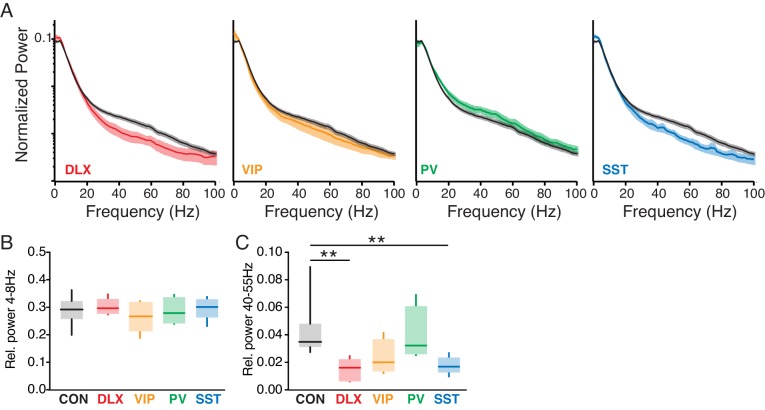
Altered hippocampal activity patterns in Mecp2 mutants.(A) Population-averaged normalized hippocampal CA1 power spectra during quiescent sitting periods for Dlx5/6 mutants (red; n = 5), VIP mutants (orange; n = 5), PV mutants (green; n = 4), and SST mutants (blue; n = 6) compared to Mecp2f/y controls (black; n = 9). (B) Population-averaged hippocampal relative LFP power in the theta (4–8 Hz) band in each group. (C) Hippocampal relative LFP power in the gamma (40–55 Hz) band in each group. **, p<0.01.